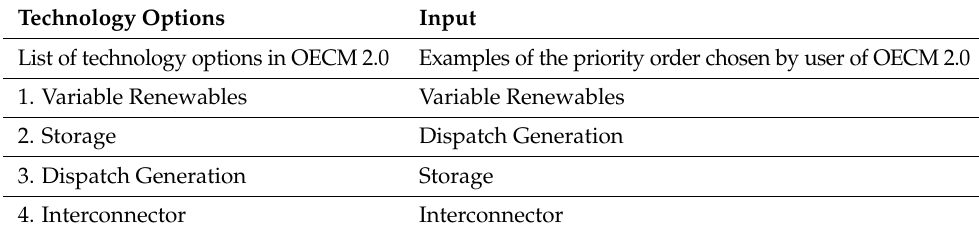
Table 9. Technology groups for dispatch order selection.